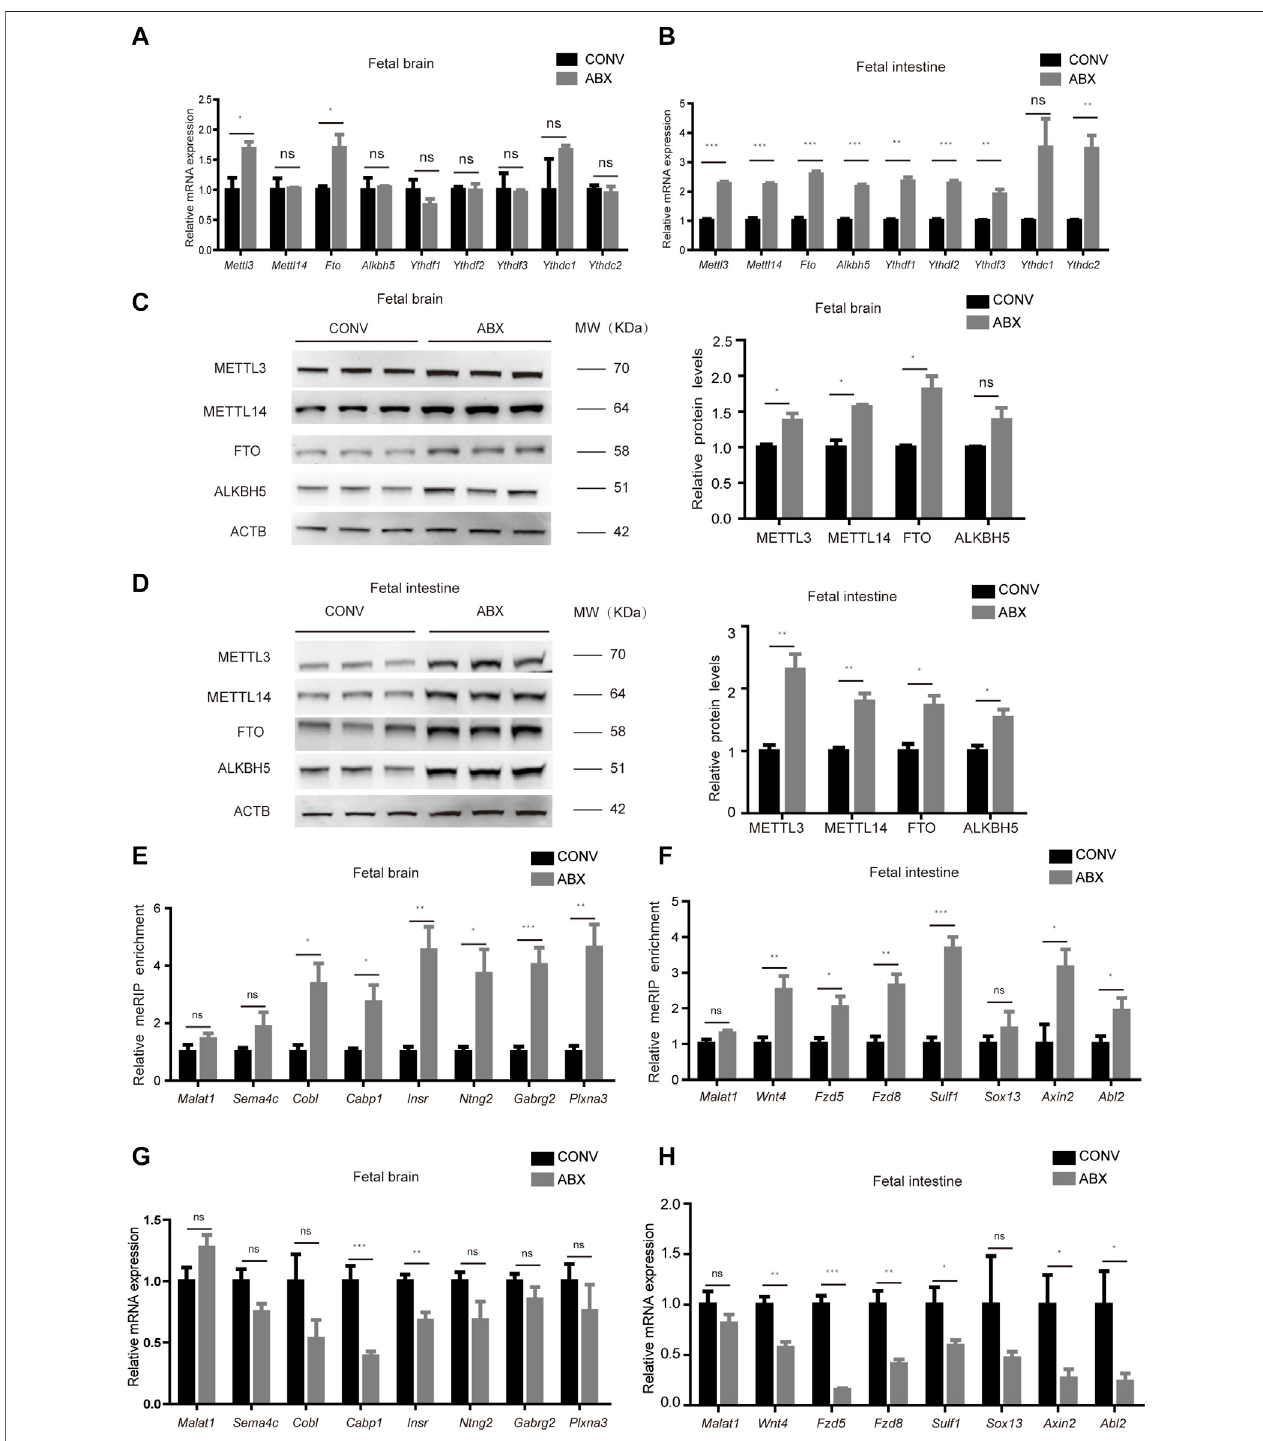
FIGURE 5 | Antibiotic treatment mostly recapitulates m 6 A alterations in the mouse fetal intestine and brain. (A,B) Relative mRNA expression levels of m 6 A writers anderasersinCONVandABXfetalbrains (A) andintestines (B) . (C,D) Westernblotshowstheproteinexpressionlevelsofm 6 Awritersanderasersinfetalbrains (C) and intestines (D) ofCONVandABXmice,andrelativeproteinexpressionlevelswerecalculatedbasedonthebanddensityinWesternblottingresults. (E,G) Validationofthe relativem 6 Aenrichmentof Sema4c , Cobl , Cabp1 , Insr , Ntng2 , Gabrg2 ,and Plxna3 inCONVandABXfetalbrains (E) andof Wnt4 , Fzd5 , Fzd8 , Sulf1 , Sox13 , Axin2 , and Abl2 inCONVandABXfetalintestines (G) bym 6 A-immunoprecipitation(IP)-qPCR. (F,H) ValidationoftherelativemRNAexpressionlevelsof Sema4c , Cobl , Cabp1 , Insr , Ntng2 , Gabrg2 , and Plxna3 in CONV and ABX fetal brains (F) and of Wnt4 , Fzd5 , Fzd8 , Sulf1 , Sox13 , Axin2 , and Abl2 in CONV and ABX fetal intestines (H) .